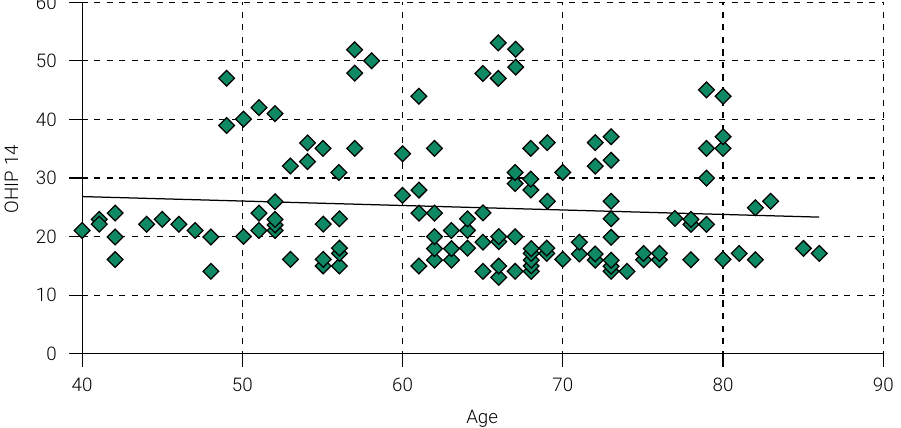
Figure 3. Relationship between age and OHIP-14 test results after applying the linear regression method (univariable linear regression model for each result).